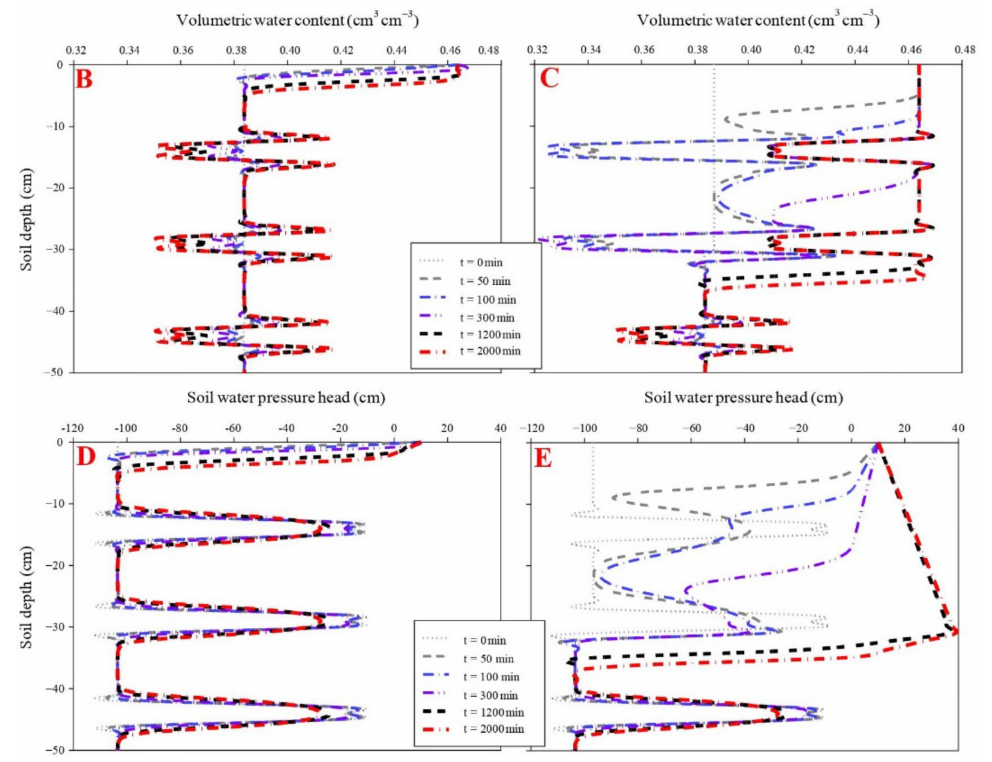
Figure 6. Effect of smooth roots of S. alterniflora on infiltration ( A ). ( B , D ) shows the dynamic variation in volumetric water content and soil water pressure head in the soil profile without fibrous maize roots. ( C , E ) shows the dynamic variation in volumetric water content and soil water pressure head in the soil profile with smooth roots of S. alterniflora . Since the clay layer and sand layer appear alternately, the saturated water holding ratio of the two layers is different, and the water content and water potential change alternately.